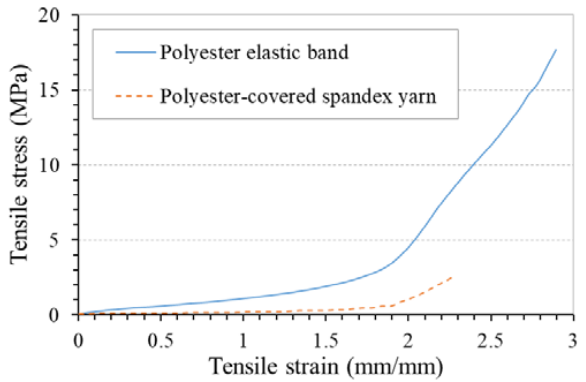
Figure 13. Tensile stress-strain curves of the weft yarns used.